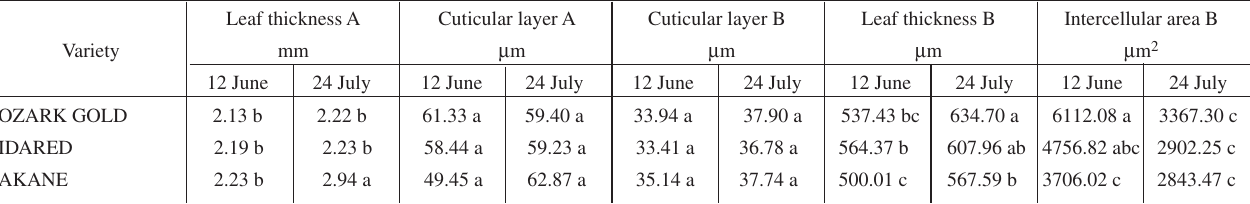
Table 2. Changes in the leaf structure of apple trees during fruit development under drought periods Leaf thickness